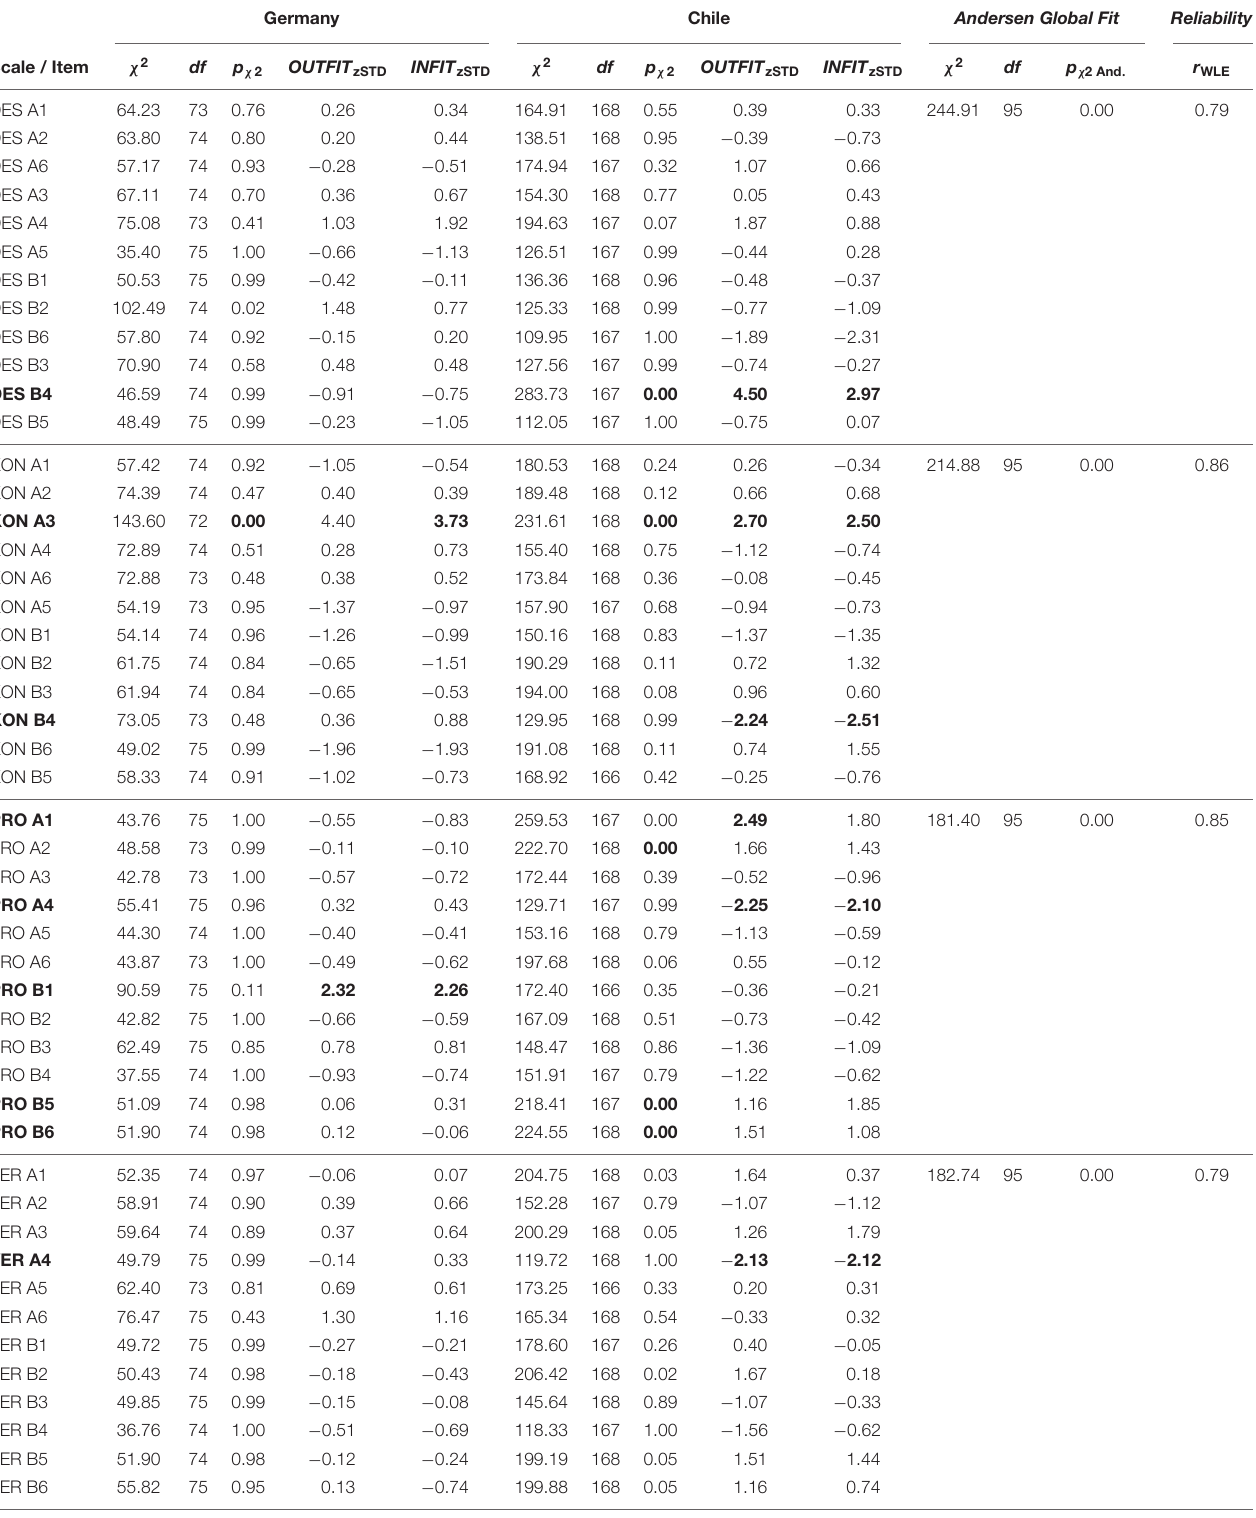
TABLE 1 | Coefficients for local and global fit indices for one dimensional scaling across both situations for five scales. Germany Chile Andersen Global Fit